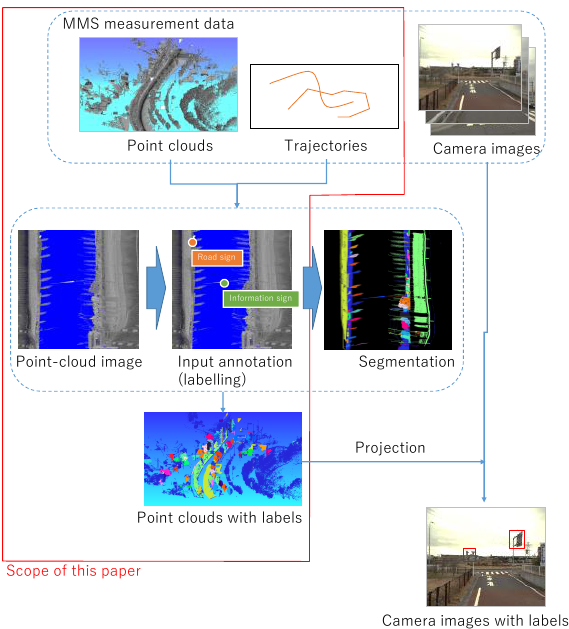
Figure 3. Our Proposal for MMS data annotation